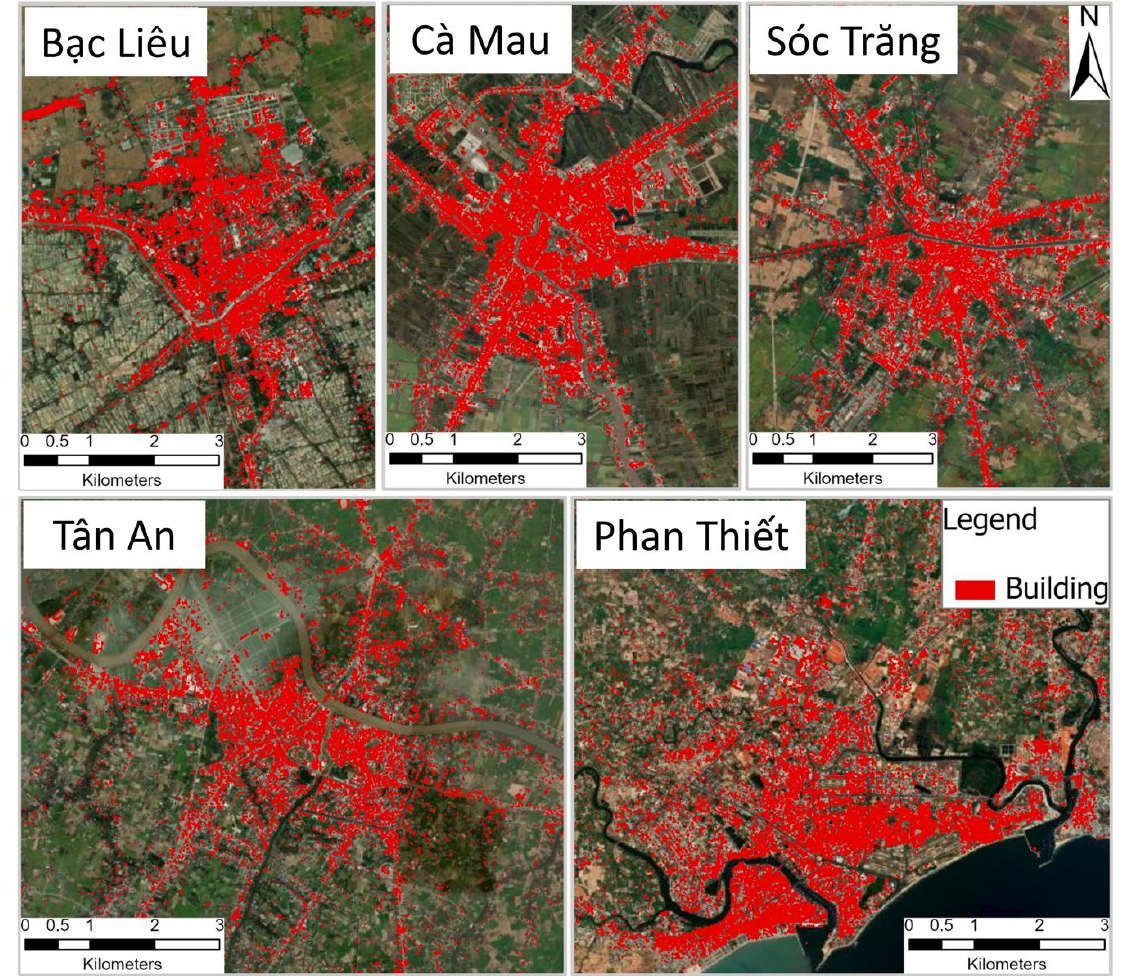
Figure 7. Classification map of five cities overlaid on ArcGIS base map: Bạc Liêu, Cà Mau, Sóc Trăng, Tân An, and Phan Thiết.